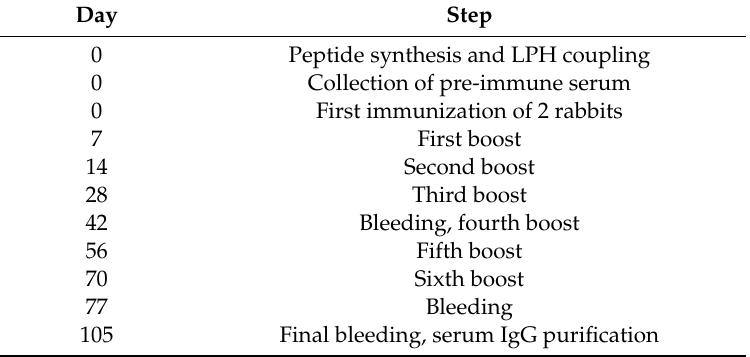
Table 1. Time scheme of rabbit